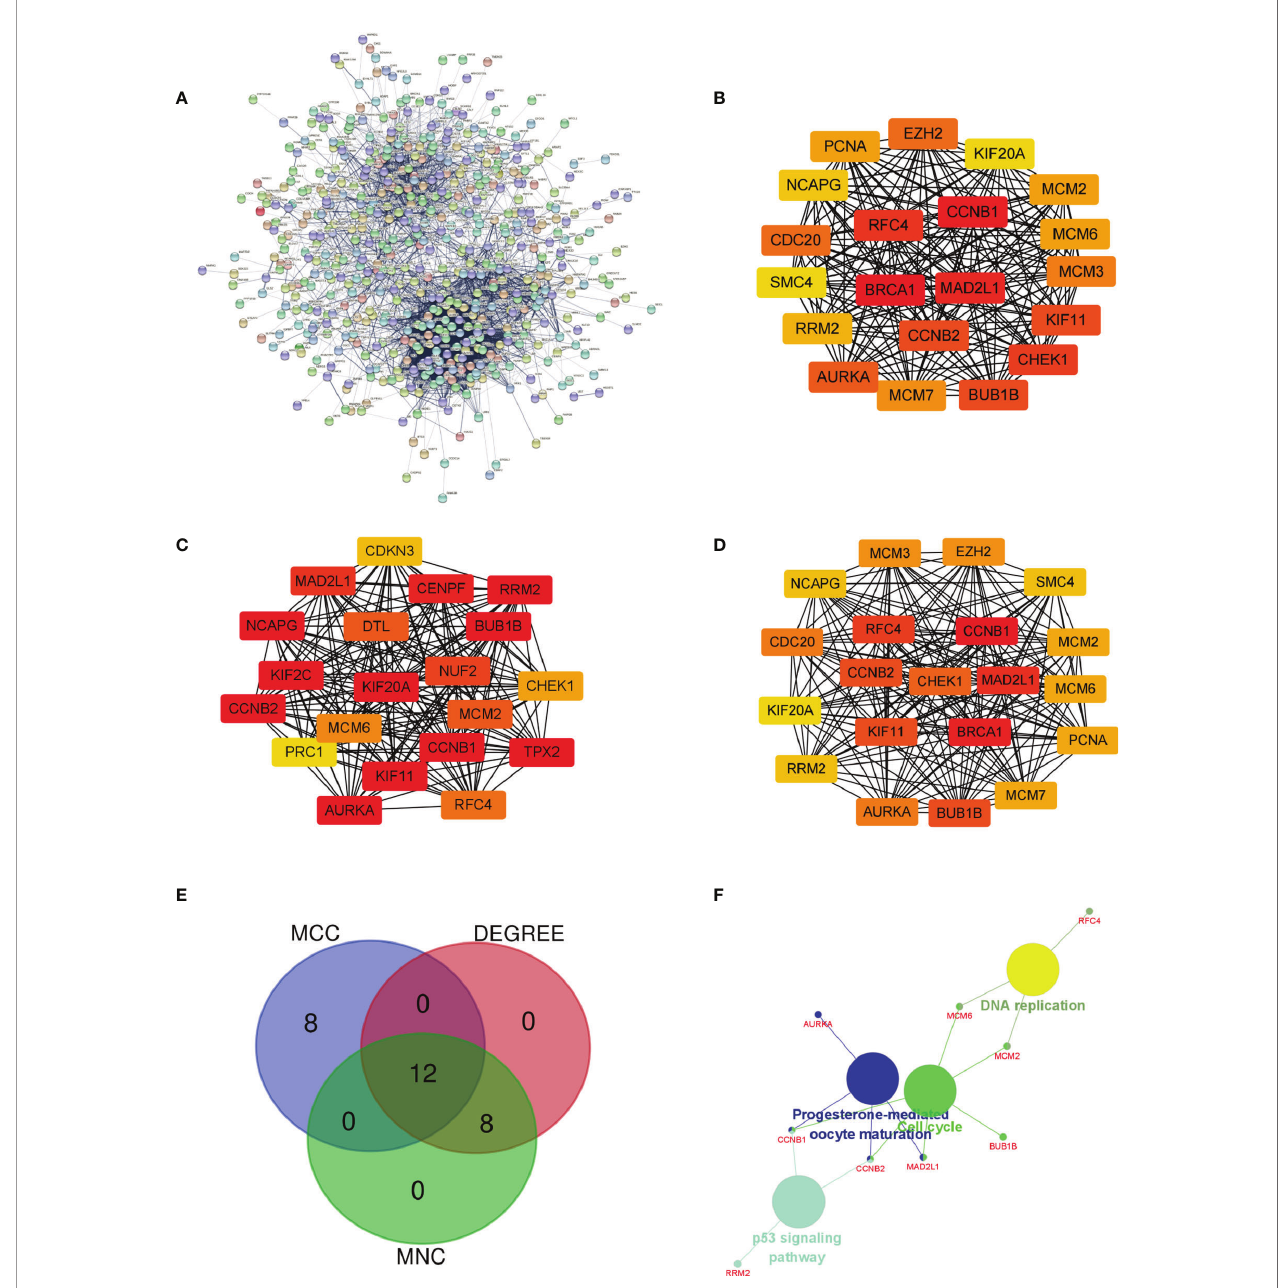
FIGURE 3 | Determination of the hub genes. (A) PPI network of DEGs in MED. (B – D) Three different metrics: DEGREE, MCC, and MNC. (E) In MED, 12 hub genes were identi fi ed using a Venn diagram, (F) The ClueGO plugin in Cytoscape software was used to visualize the fi ndings of KEGG pathway